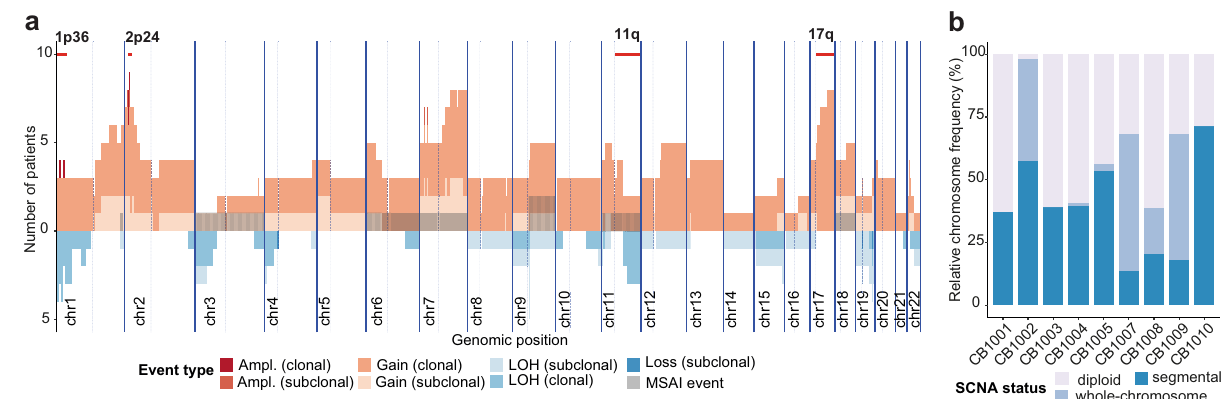
Fig. 3 Intratumour heterogeneity of somatic copy-number alterations in the neuroblastoma cohort. a Overview of Somatic copy-number alterations (SCNA) events per-cytoband aggregated across 9 patients. Ampli fi cations and gains are visible in the upper half, loss of heterozygosity (LOH) and deep losses in the lower half of the plot. Clinically relevant chromosome regions 1p36, 2p24, 11q and 17q are highlighted in red at the top. Mirrored subclonal allelic imbalances (MSAI) are indicated by grey shading. MYCN locus: 2p24 b Fraction of chromosomes affected by segmental or whole-chromosome gains and losses are depicted for the low-and intermediate-risk patients (CB1007, CB1009) and the high-risk patients (CB1001, CB1002, CB1003, CB1004, CB1005, CB1010).